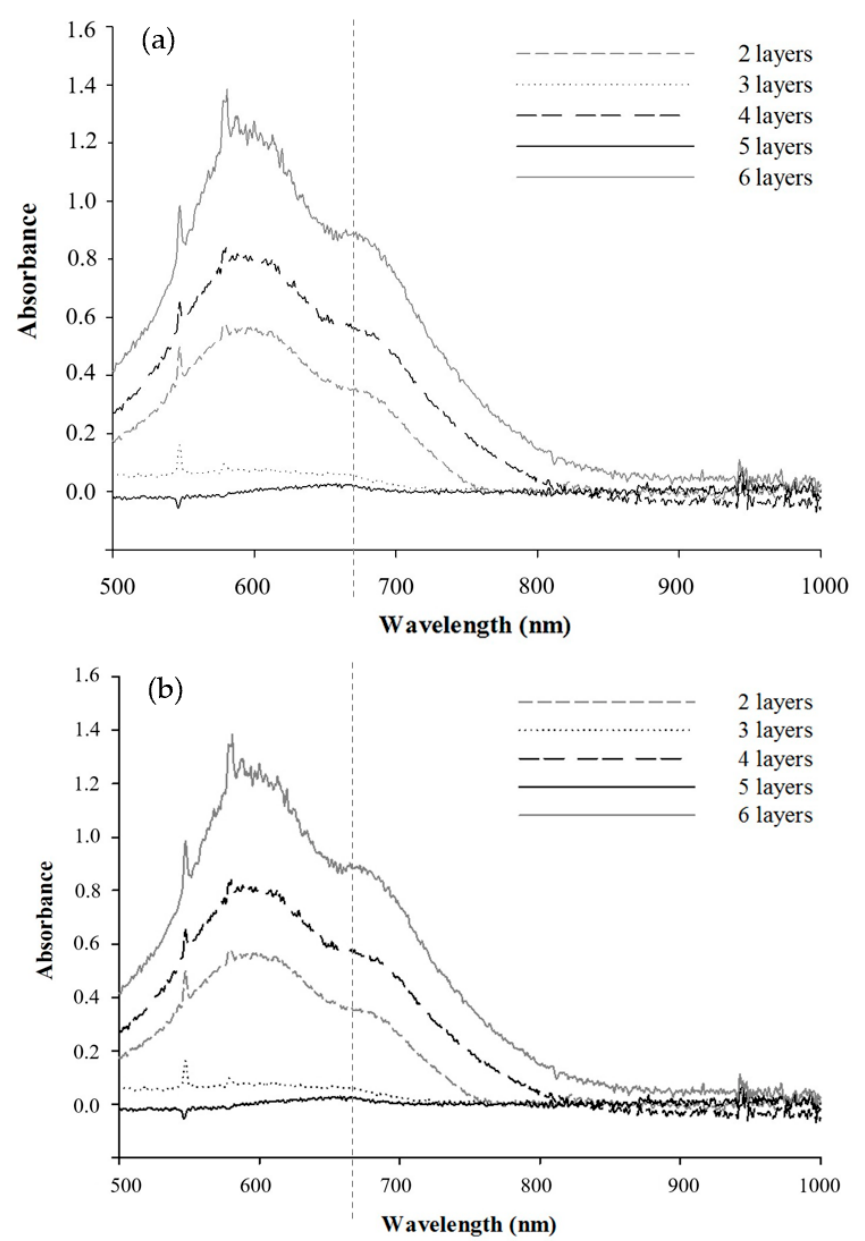
Figure 3. Absorbance-number of layer curves for PDAD/PSS deposited 1.0 M NaCl: ( a ) top surface of poly(S/DVB)HIPE; ( b ) cross section of poly(S/DVB)HIPE.